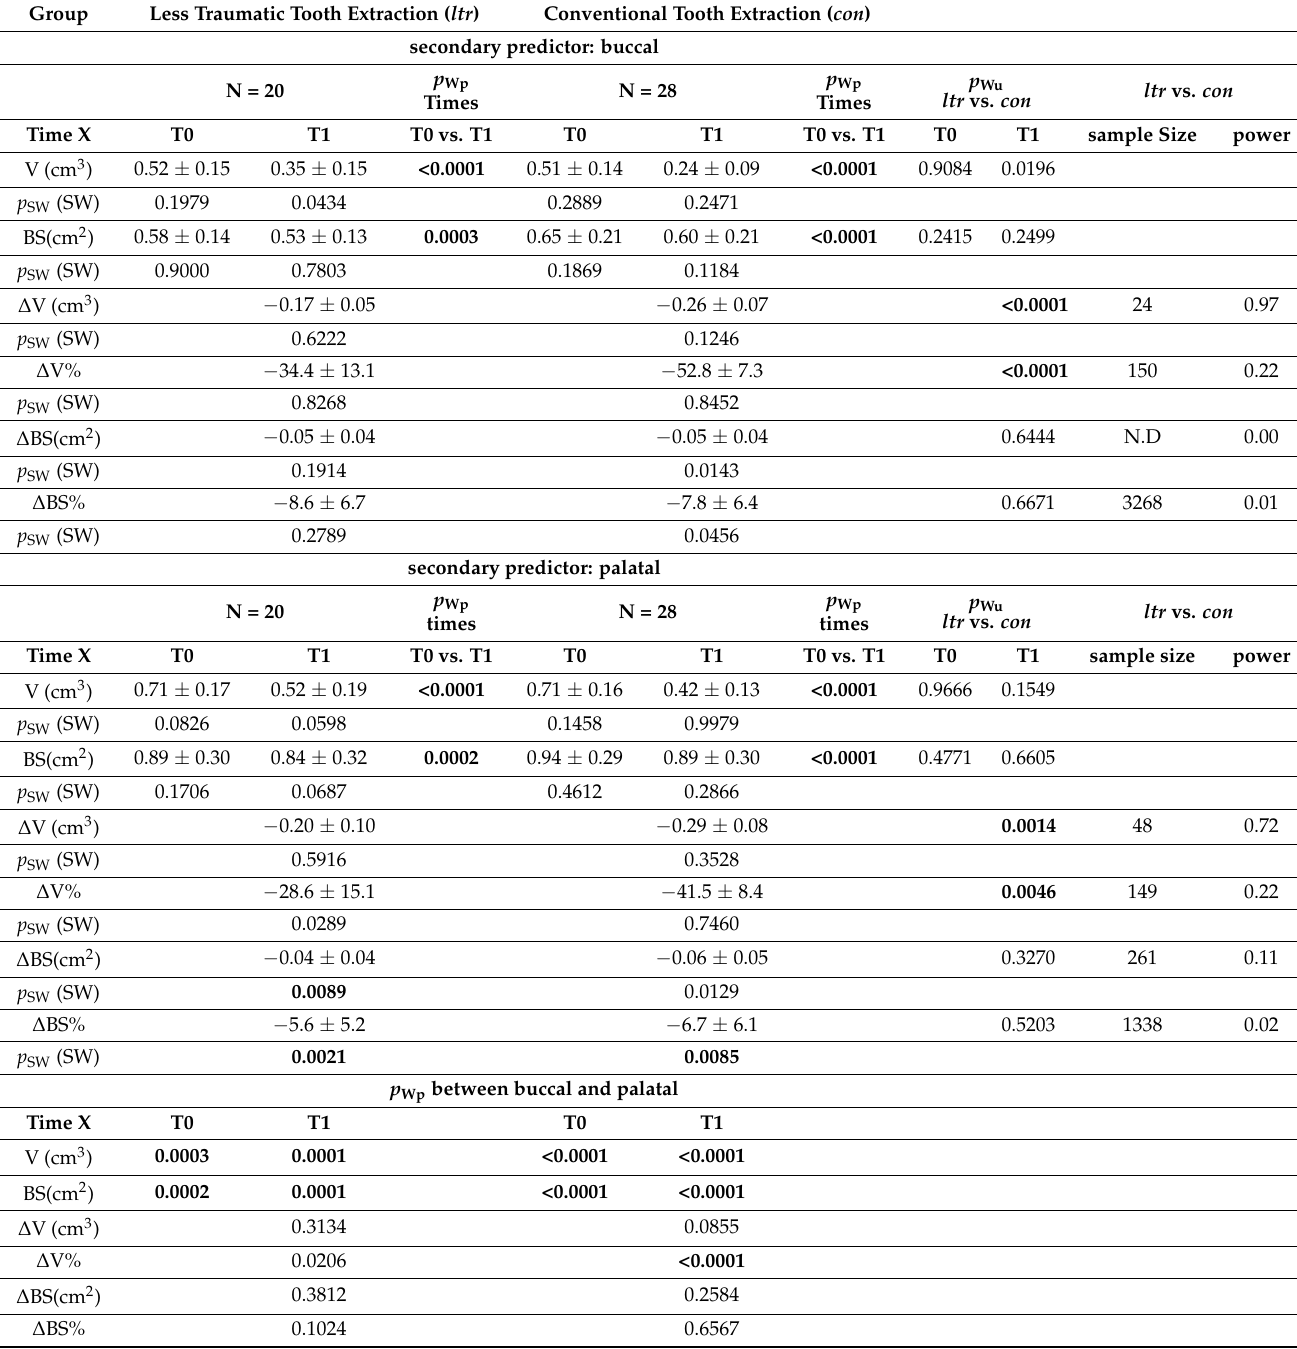
Table 3. Anatomical variables and outcomes for the group less traumatic tooth extraction ( ltr ) and conventional tooth extraction (con), at baseline (T0) and at 4 months (T1, when the site was healed) for the secondary predictor tooth aspect and location: buccal versus palatal and bicuspid versus molar. Volume of alveolar ridge or V, basal surface or BS, and outcome variables (percentages of Volume and Basal Surface change). Shapiro–Wilk test significance ( p SW ); Wilcoxon rank-sum test significance between unpaired data ( p Wu ); Wilcoxon signed-rank test significance between paired data ( p Wp ). Statistically-significant values are in bold. Report of calculated sample size (with power = 0.99) and calculated